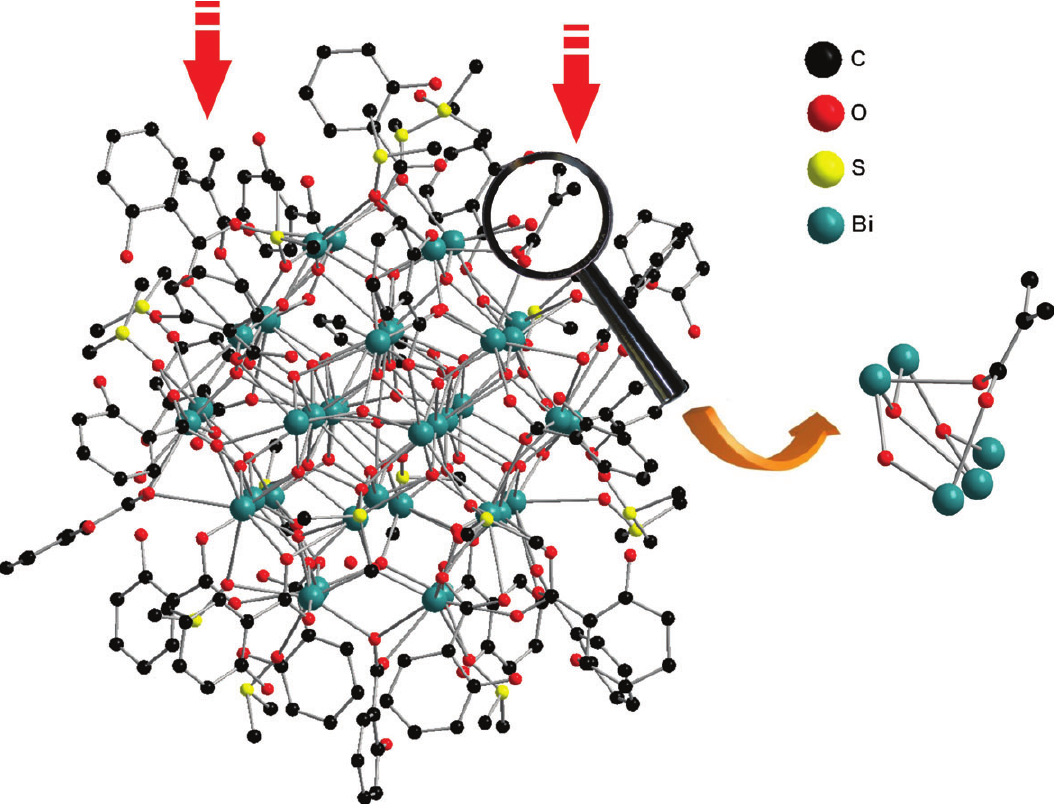
Figure 4 Ball-and-stick model of [Bi nation of the two methacrylate ligands. H-atoms are omitted for